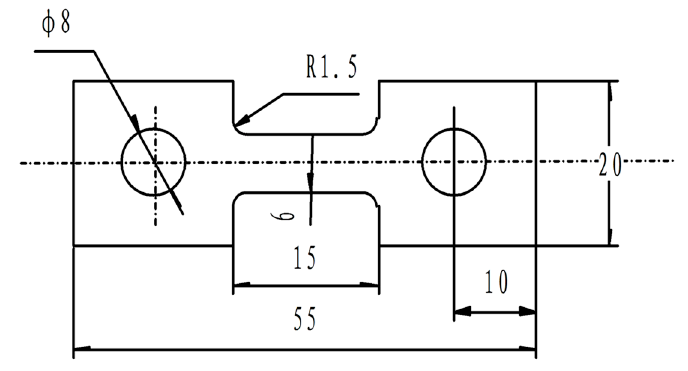
Figure 1. Schematic diagram of superplastic tension specimen (Unit: mm).